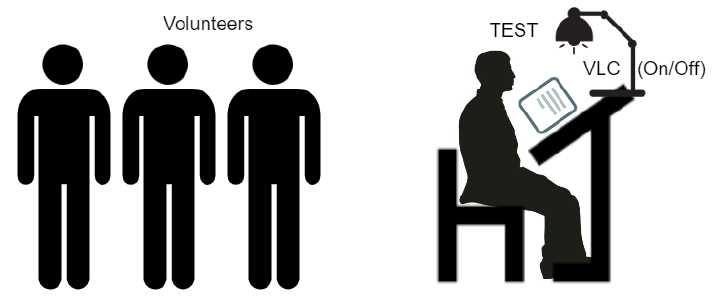
Figure 1. Sketch of the test set